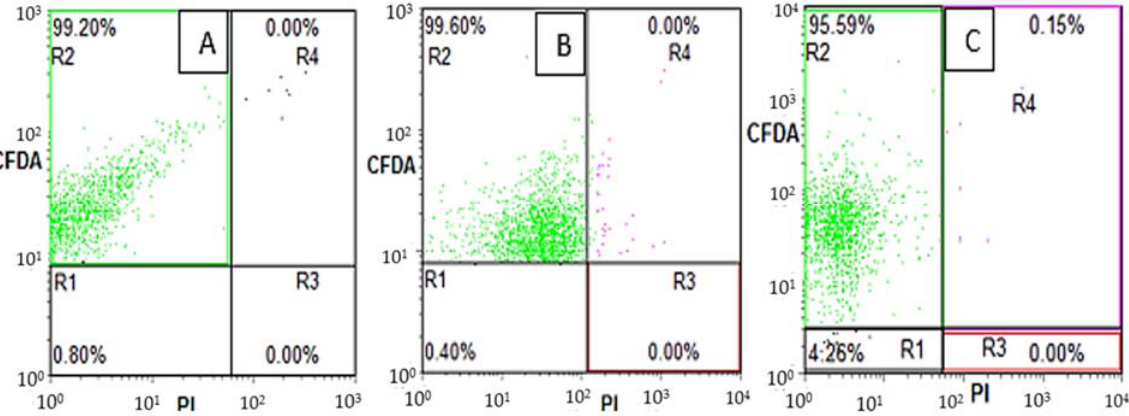
Figure 4. Flow cytometric dot plots of B. adolescentis upon treatment with 300 ( A ), 600 ( B ) and 900 ( C ) μ m EU nano ‐ emulsion after 36 h of treatment. R1 (cell debris), R2 (viable cells), R3 (membrane ‐ damaged cells) and R4 (sub ‐ lethal cells).